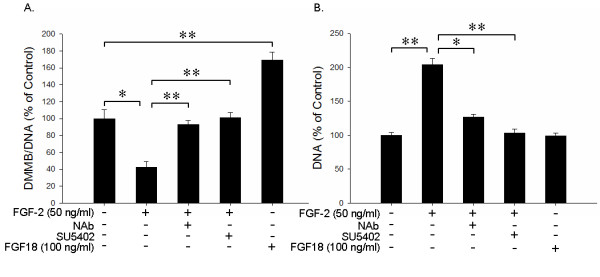
The effect of FGF-2 on proteoglycan accumulation and cell proliferation. Human articular chondrocytes were cultured in alginate beads with indicated treatments for 21 days before assaying for proteoglycan and DNA content. (A) Proteoglycan accumulation was assessed by dimethylmethylene blue (DMMB) assay, normalized by DNA content. (B) Cellular proliferation was quantified by total DNA content in beads from each treatment group. * P < 0.05; ** P < 0.01. FGF, fibroblast growth factor.